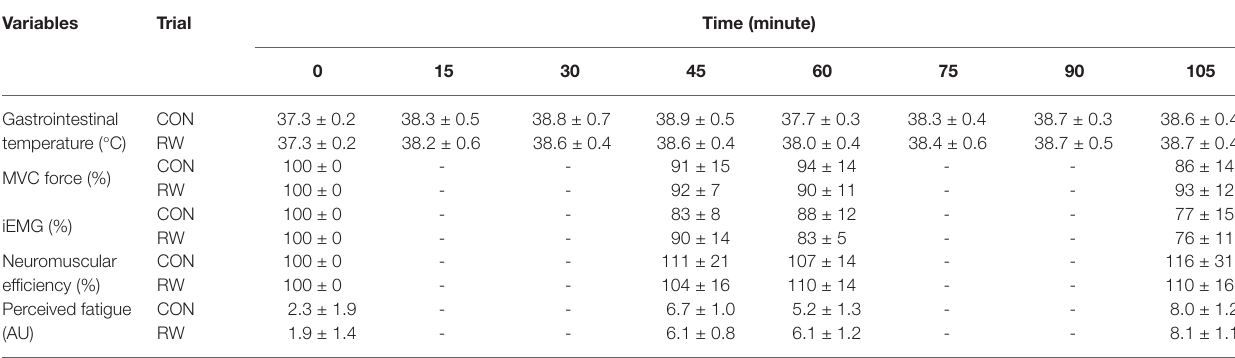
TABLE 1 | The gastrointestinal temperature, maximal voluntary contraction (MVC) force, integrated electromyogram (iEMG), neuromuscular efficiency, heart rate (HR), and perceived fatigue between the two trials. Variables Trial